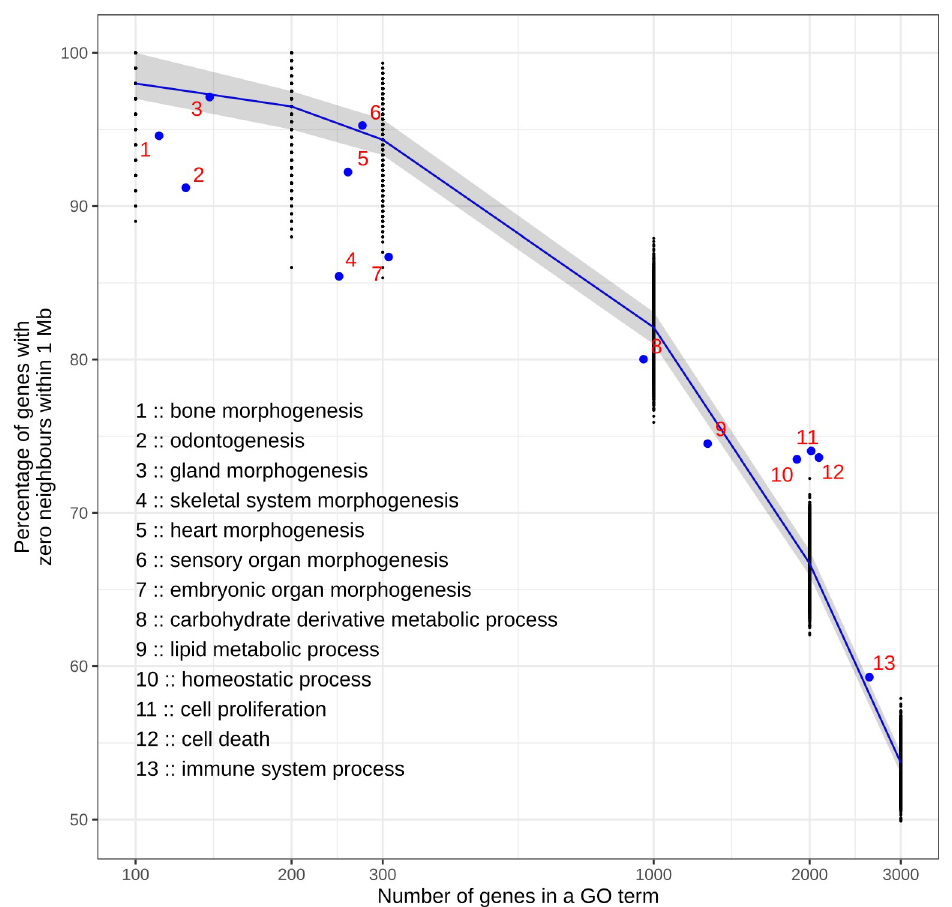
Fig 3. Real GO terms with lower gene numbers are slightly more clustered in the genome than artificial GO terms with the same gene numbers. Artificial GO terms with different numbers of genes were made with randomly selected genes and their distribution across the genome was measured. For each group size, 10,000 simulations were executed and for each simulation the percentage of genes with zero within-1Mb-neighbours with the same artificial GO term were counted (black dots). Real GO terms are marked with blue dots. See S2 Table for GO IDs. The blue line is median, and the shadow shows the observations between 1st and 3rd